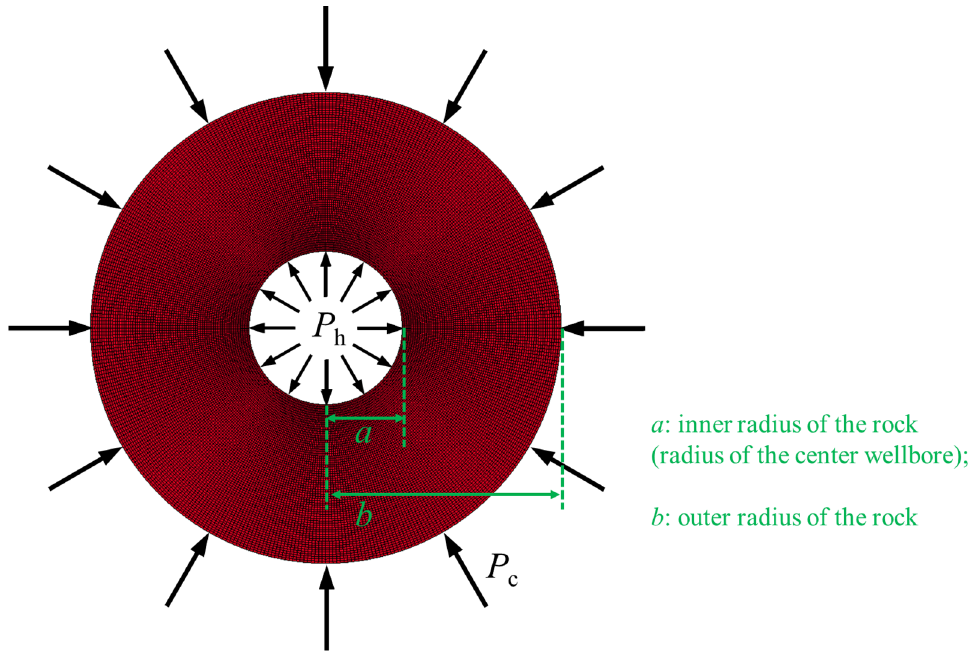
Figure 6. Configuration of the numerical